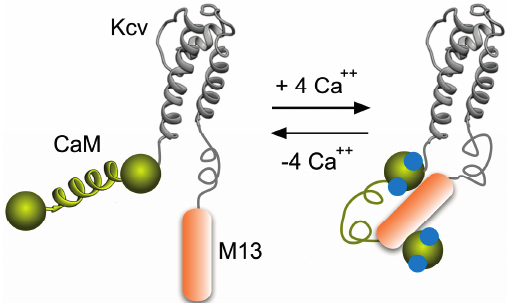
Figure 1. Cartoon representation of the expected mode of operation of the biosensor. A single Kcv subunit fused to the calcium-modulated protein CaM and its interacting peptide M13 is shown in the Ca ++ -unbound ( left ) and in the bound ( right ) state. When four Ca ++ ions bind to the four CaM binding sites, the sensor protein undergoes a conformational change and enfolds the M13 peptide. The molecular rearrangement of CaM and M13 affects the Kcv pore properties leading to a change in measurable